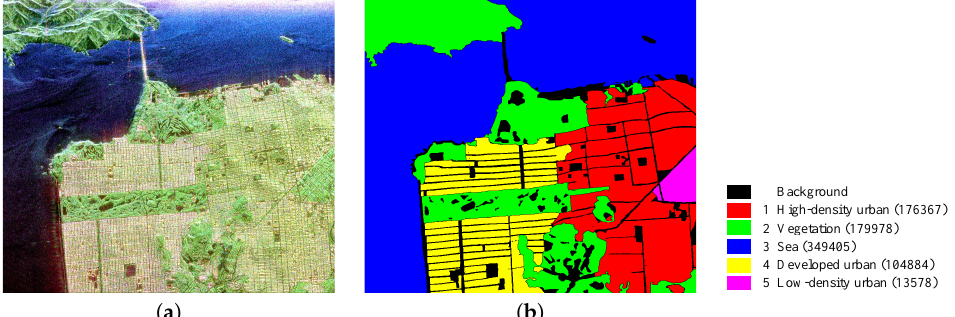
Figure 10. San Francisco dataset. ( a ) Pauli RGB; ( b ) ground truth and corresponding legend (note that the number of each class is given in